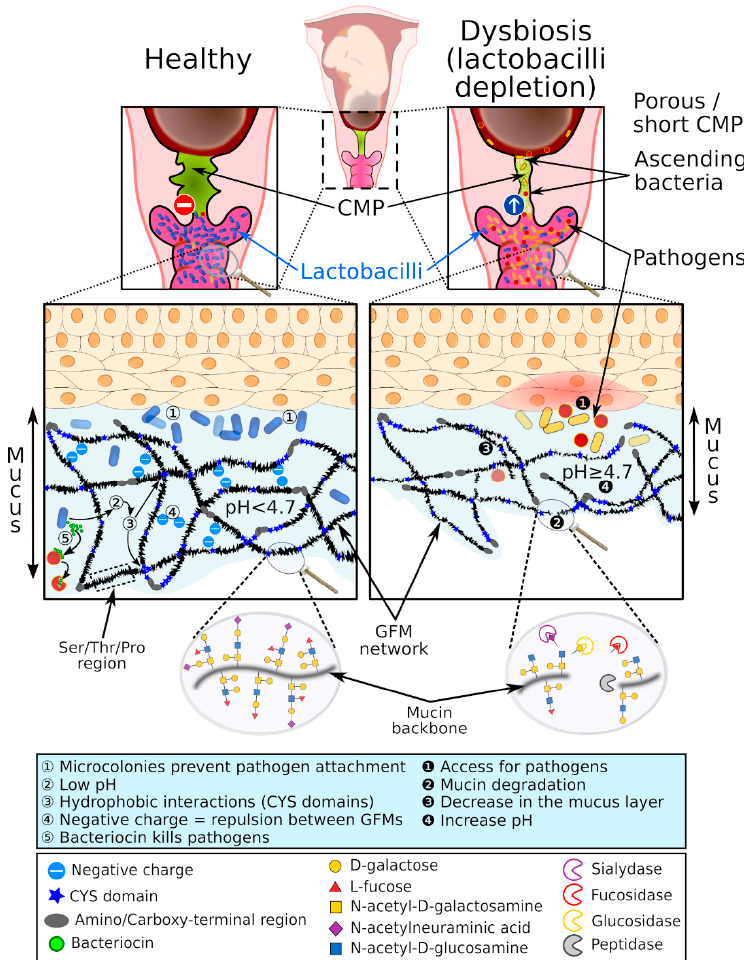
Figure 4. Bacterial vaginosis in the pregnant woman predisposes to ascending bacterial infection. During a healthy pregnancy, women produce a dense cervical mucus plug (green) that prevents vaginal flora from reaching the uterine cavity (left). During vaginal dysbiosis (right), the depletion of lactobacilli (blue) promotes the proliferation of pathogens in the vagina (red and yellow), which can more easily reach the uterine compartment if the cervical mucus plug (CMP) is smaller and / or too